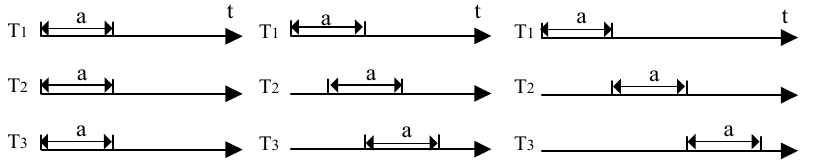
Figure 12. Parameter analysis of rolling horizon window. ( a ) Comparison of average solving time at different scales; ( b ) comparison of upper-level function values under small scale; ( c ) comparison of upper-level function values under medium scale; ( d ) comparison of upper-level function values under large scale; ( e ) comparison of lower-level function values under different scales.